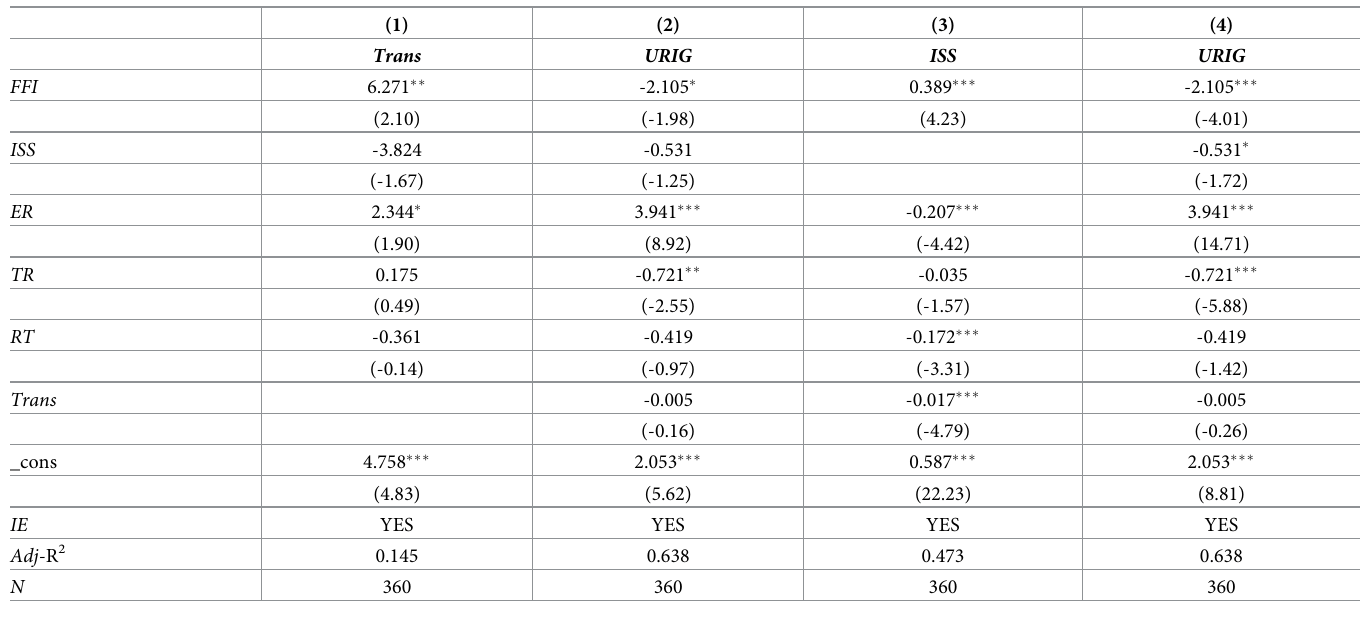
Table 6. Results of the transmission